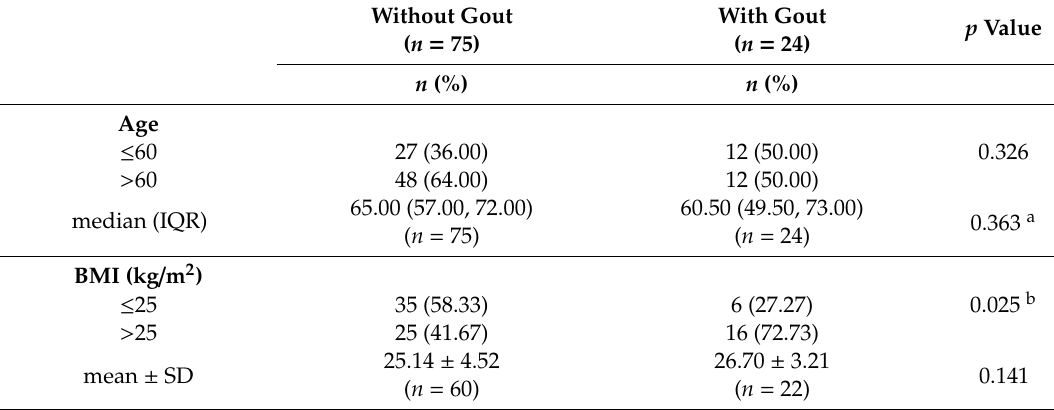
Table 1. Di ff erence in clinical features and laboratory findings between uric acid urolithiasis patients with and without